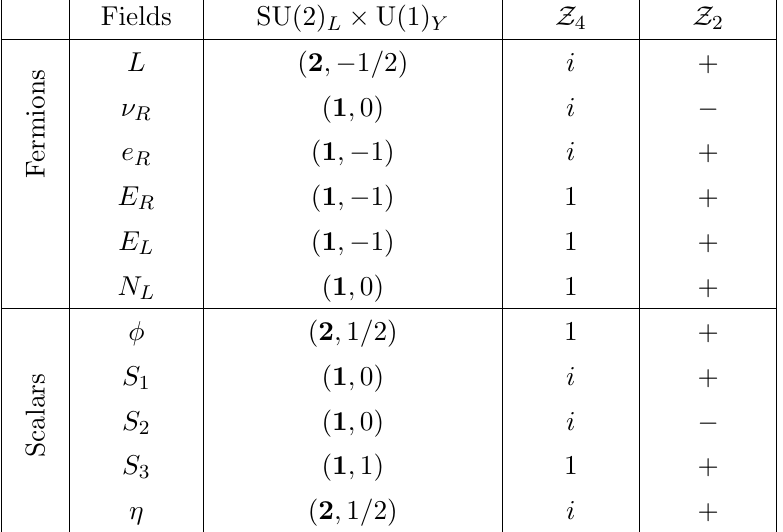
symmetry forbids Z 2